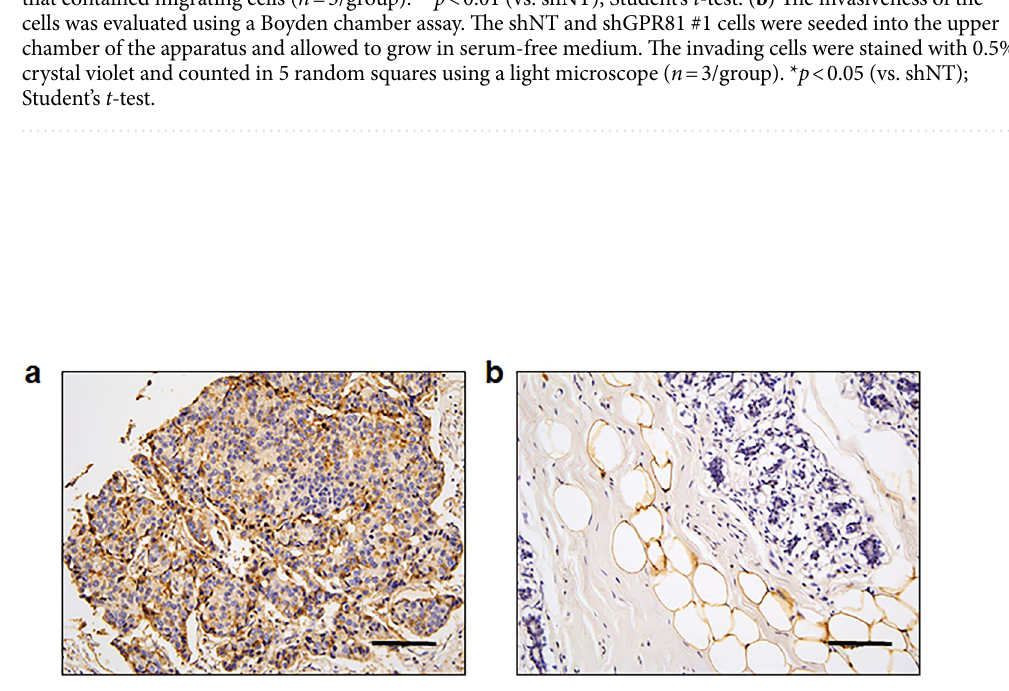
Figure 8. Representative histological views of GPR81 in human breast cancer and normal breast tissue. The expression of GPR81 in human breast cancer ( a ) and adjacent normal breast tissue ( b ) was analyzed by immunohistochemistry using human tissue arrays. Note that GPR81 was expressed in breast cancer tissue and white adipocytes found in normal breast tissue. Scale bar 100